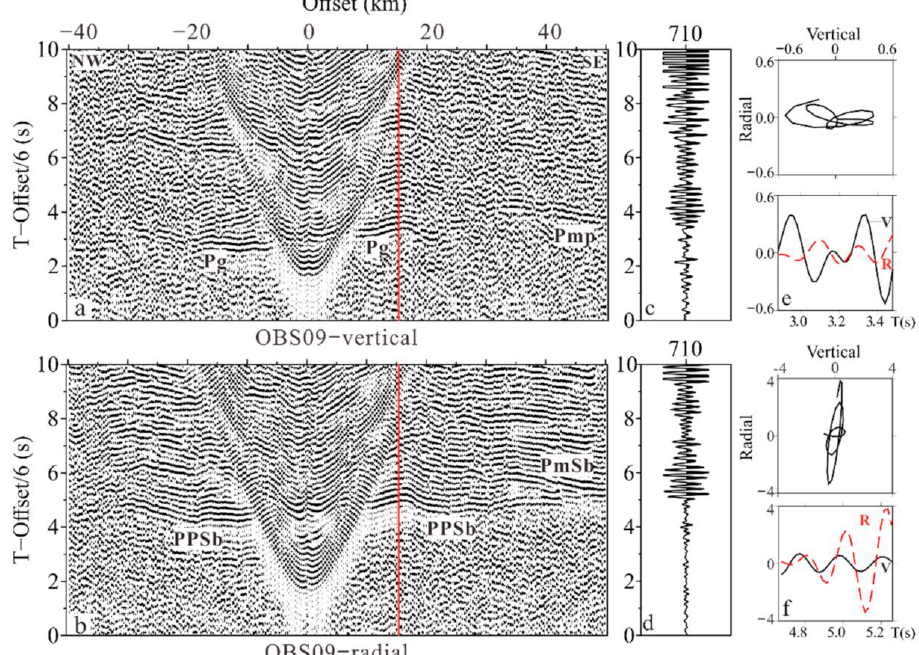
Figure 4. ( a ) Vertical and ( b ) radial component seismic profiles of OBS 09, reduced by 6 km/s. ( c ) and ( d ) show the waveform of the 710th trace in the vertical and radial component profiles, respectively. ( e , f ) correspond to the particle motion paths of the 710th trace in the vertical component (2.88–3.48 s) and radial component (4.66–5.26 s),